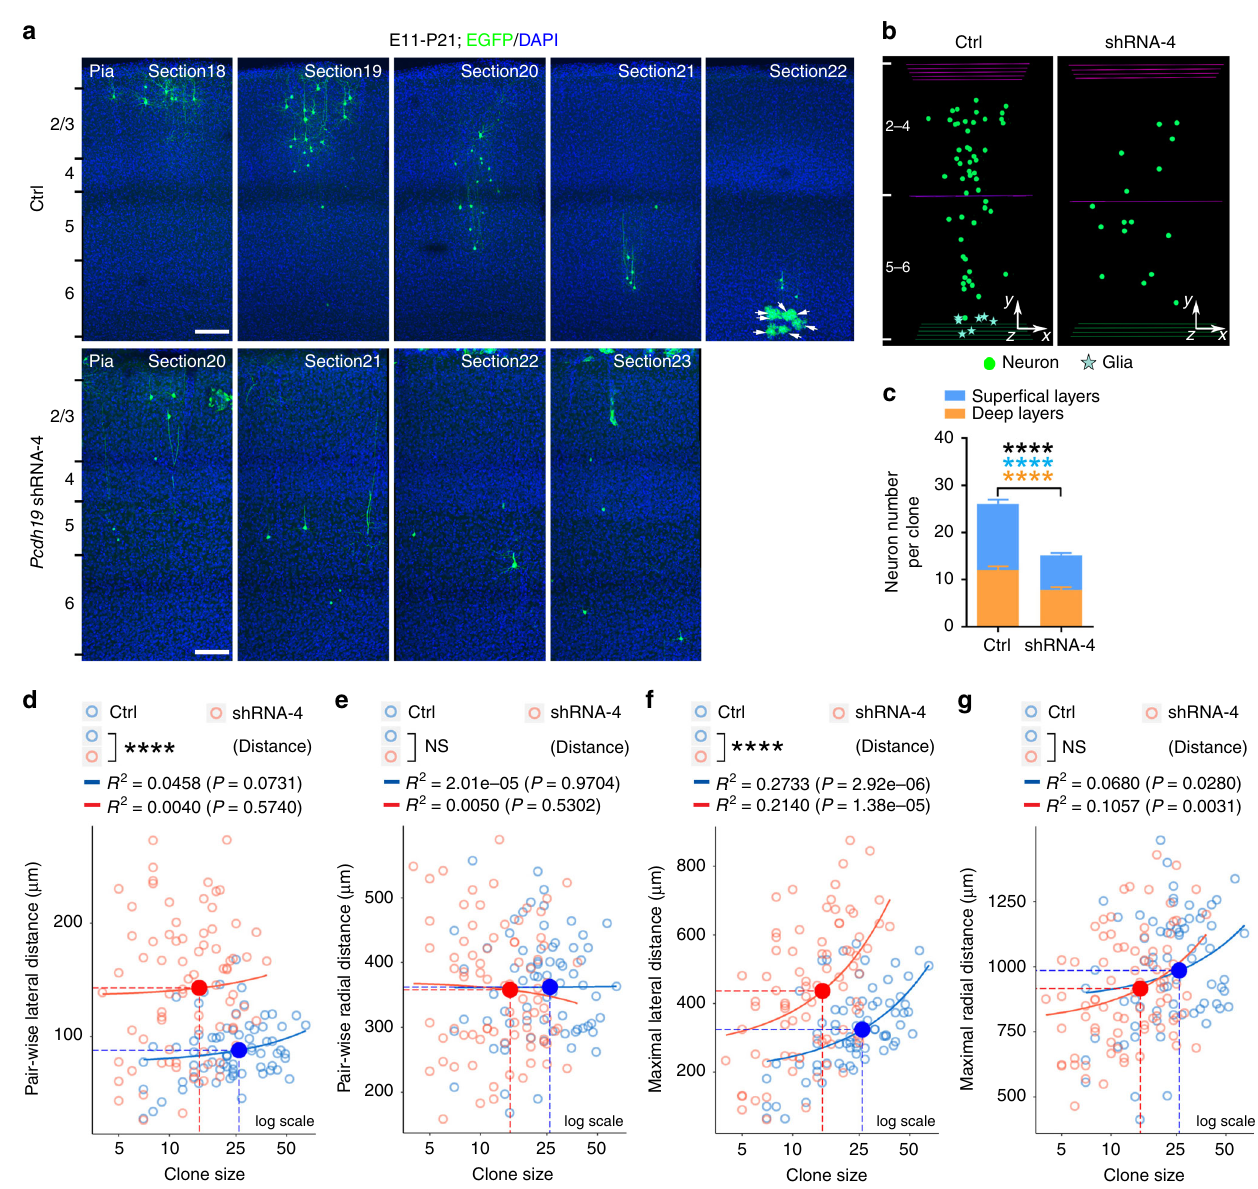
Fig. 5 PCDH19 knockdown causes neuronal and lateral dispersion defects. a Representative confocal images of P21 excitatory neuron clones expressing EGFP and control shRNA (top) or Pcdh19 shRNA-4 (bottom). Arrows indicate glial cells. Scale bars: 100 μ m. b 3D reconstruction images of the control and Pcdh19 shRNA-4 clones shown in ( a ). c Quanti fi cation of the number of neurons in individual clones expressing control ( n = 71) or Pcdh19 shRNA-4 ( n = 81). d , e Quanti fi cation of the pair-wise lateral and radial distances between neurons in clones expressing control ( n = 71) or Pcdh19 shRNA-4 ( n = 81). f , g Quanti fi cation of the maximal lateral and radial distances between neurons in clones expressing control ( n = 71) or Pcdh19 shRNA-4 ( n = 81). Data are presented as mean ± SEM. (**** P < 0.0001; NS not signi fi cant; unpaired t